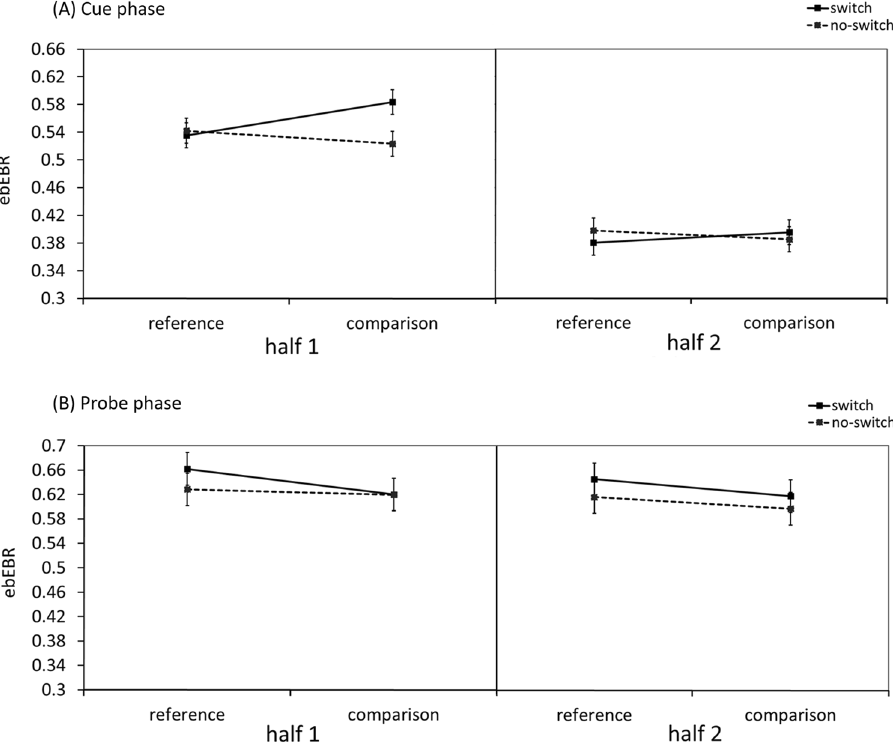
Figure 5. The ebEBR results of Experiment 3. The ebEBR as a function of Segment part, Trial-Type and Switching is presented. The 4-sec segment length after cue presentation ( A ) and after probe presentation ( B ) was divided into two parts, each of 2-sec. In the cue phase ( A ), the switching effect was observed only in comparison trials and only in the first half of the segment. In the probe phase ( B ), the switching effect in reference trials was observed in both segment parts. Error bars represent 95% confidence